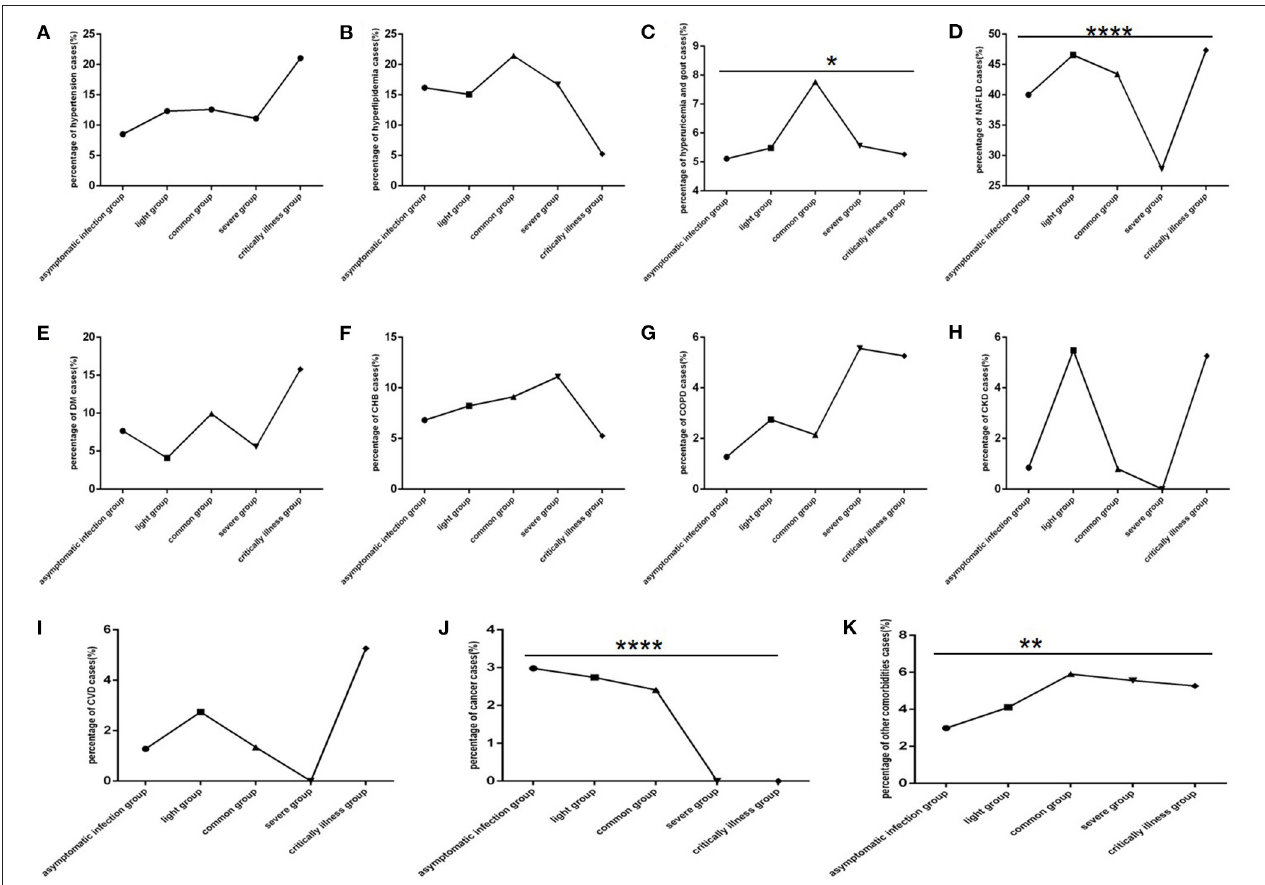
FIGURE 6 | Comparison of the percentage of each comorbidity case among different clinical type groups ( n = 718; asymptomatic infection, light, common, severe and critically ill groups, n = 234, 73, 371, 18, and 19, respectively). COVID-19, coronavirus disease 2019; NAFLD, non-alcoholic fatty liver disease; DM, diabetes mellitus; CHB, chronic hepatitis B; COPD, chronic obstructive pulmonary disease; CKD, chronic kidney disease; CVD, cardiovascular disease. (A) Hypertension. (B) Hyperlipidaemia. (C) Hyperuricaemia and gout. (D) NAFLD. (E) DM. (F) CHB. (G) COPD. (H) CKD. (I) CVD. (J) Cancer. (K) Other. Unpaired one-way ANOVA was used for intergroup comparisons (D, J, P all < 0.0001; K, P all < 0.01; C, P < 0.05; A, B, E, F, G, H, I, all P > 0.05). * p < 0.05, ** p < 0.01, **** p <